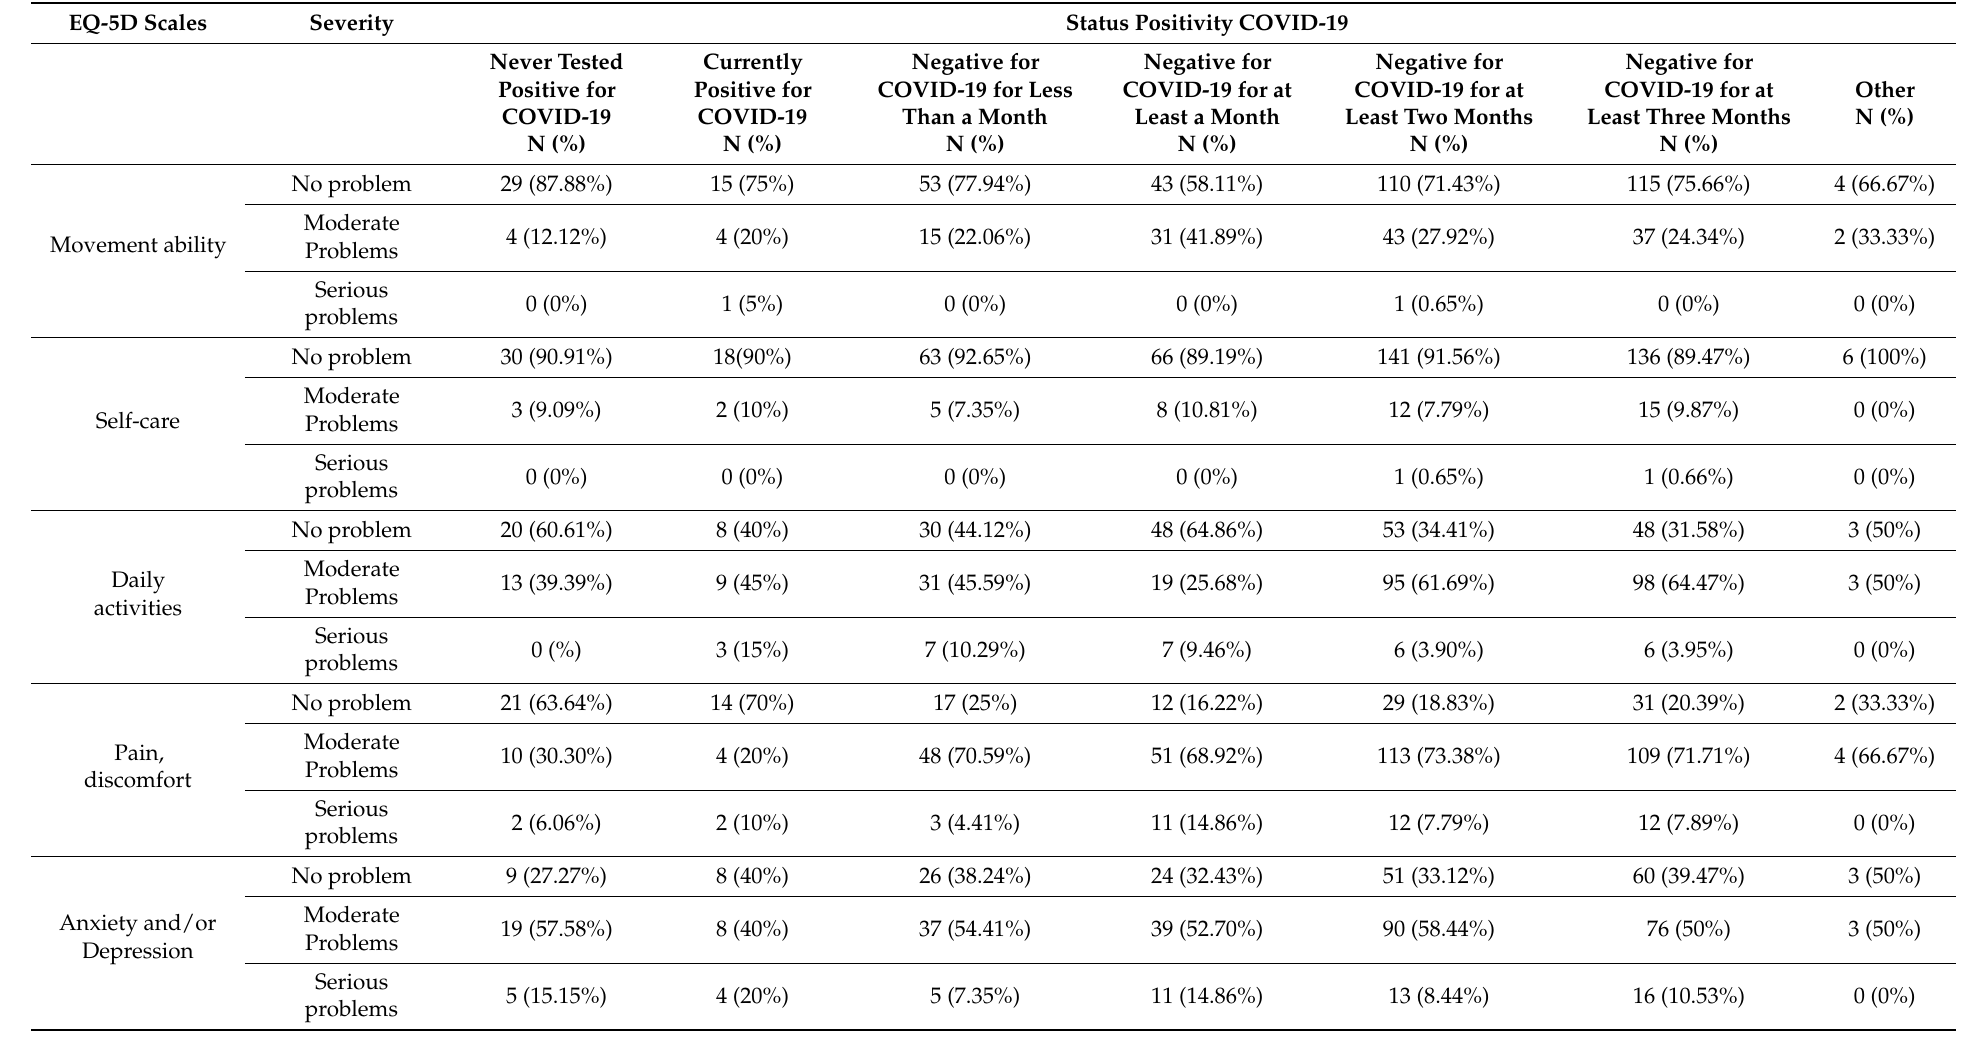
Table 5. Number and percentage of subjects who responded to individual items in the five dimensions investigated by the EQ-5D, classified by COVID-19 Status and EQ-5D Scale. EQ-5D